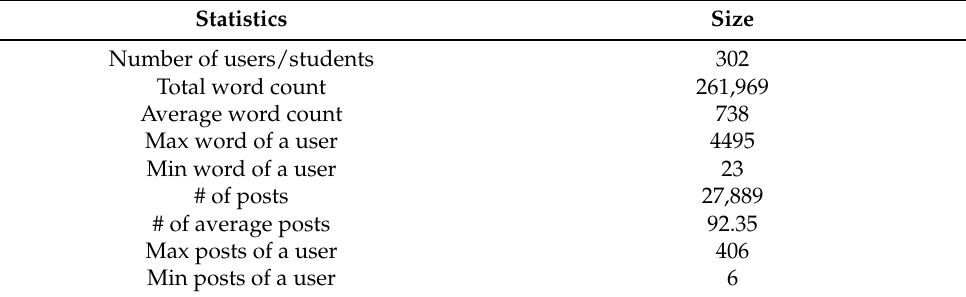
Table 1. Statistics of Facebook